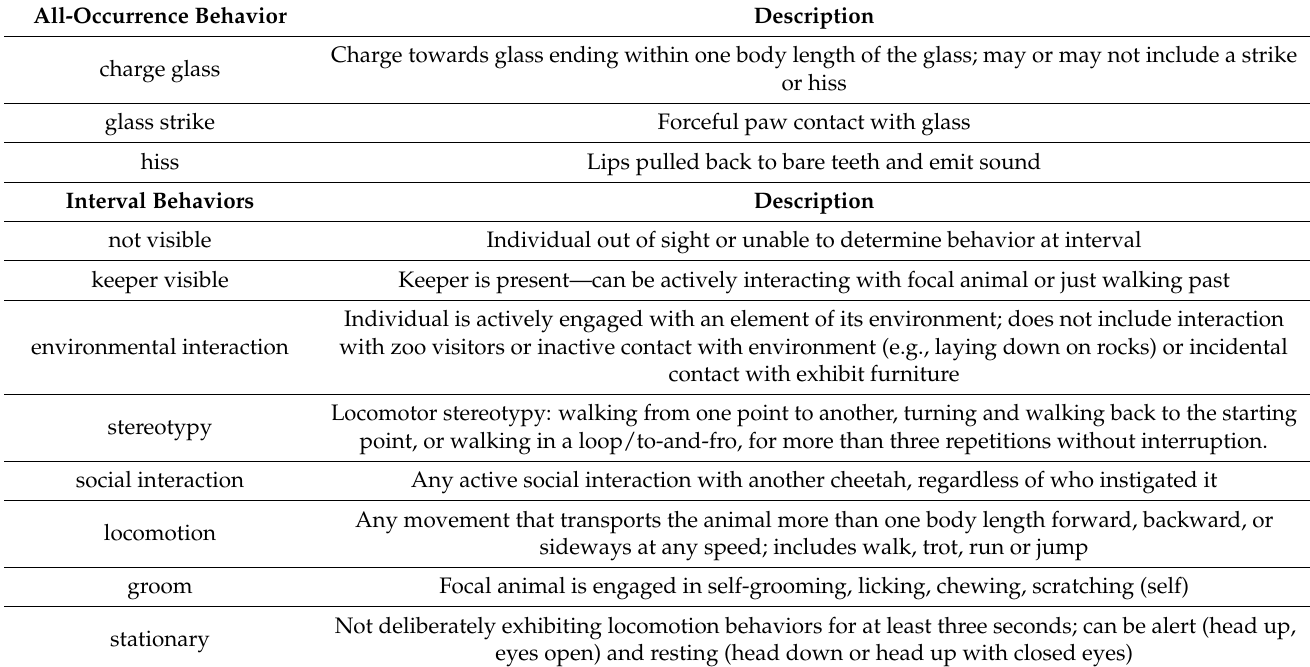
Table 2. Pre-established cheetah ethogram